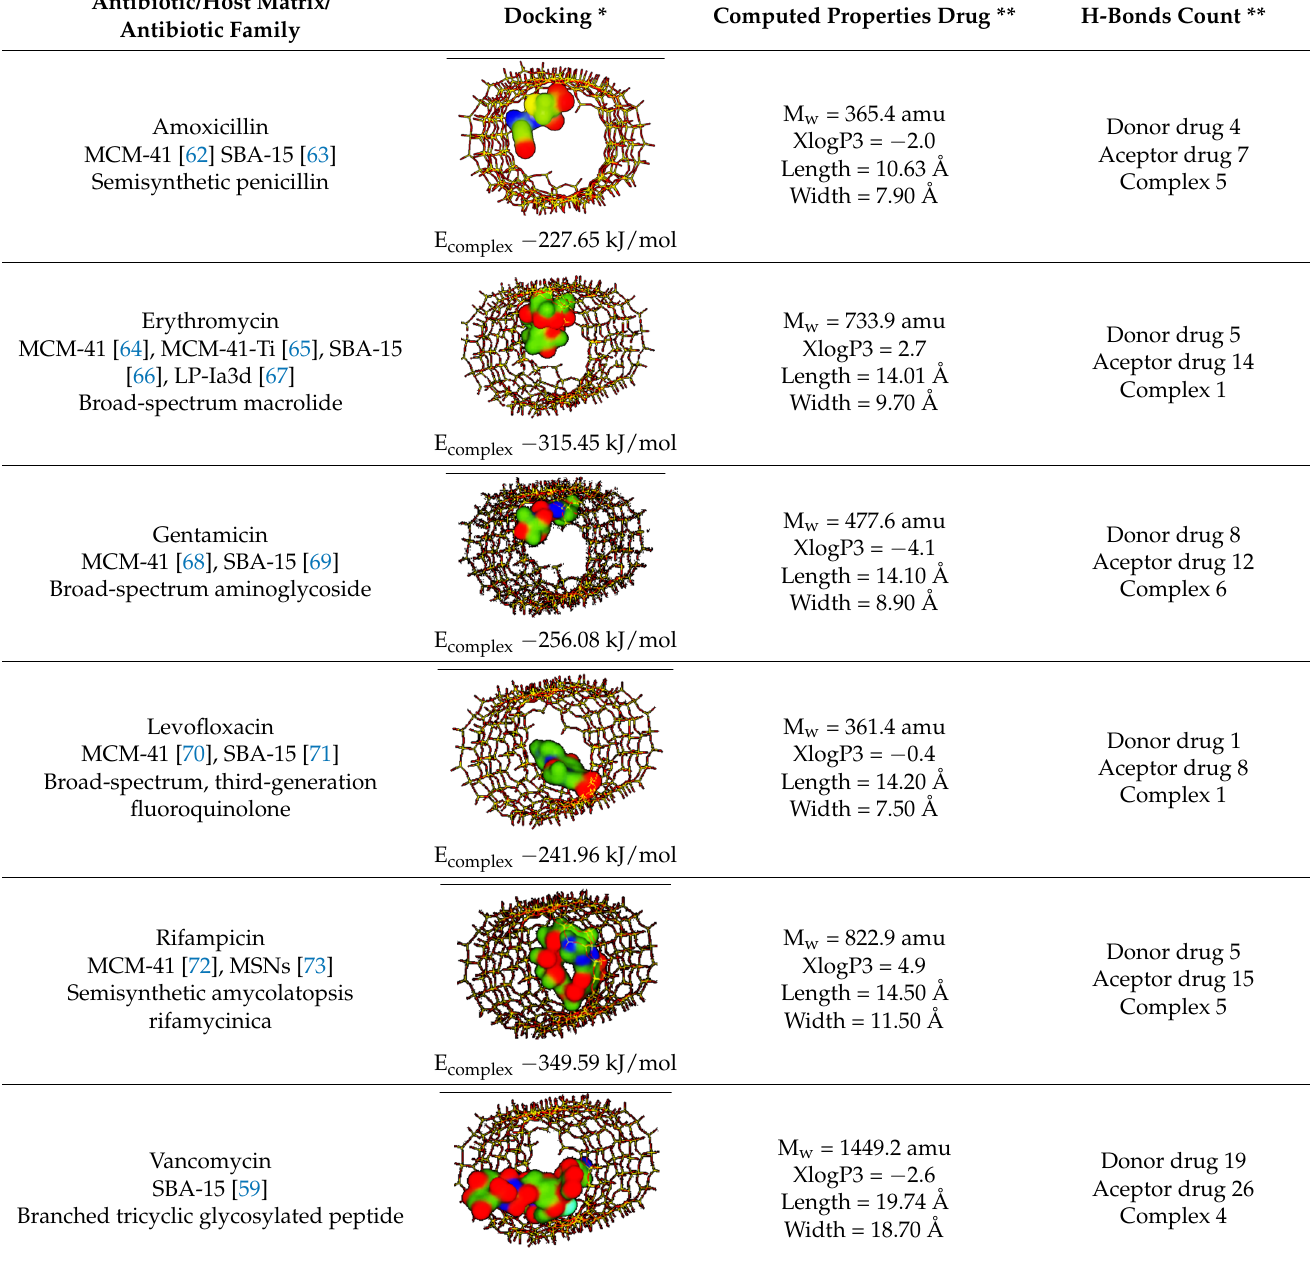
* MCM-41 host matrix is essentially composed of negative formal charges; in drugs, red represents negative formal charges while the blue color represents positive formal charges, as shown in the electrostatic potential color scale: ; E complex is the electrostatic potential energy in the model complex, where MCM-41 was used as recep- tor and the antibiotic as ligand. ** XlogP3 (for the fast calculation of partition coefficient, logP), donor and acceptor drug H-bonds have been obtained from PubChem DataBank. Complex H-bonds have been obtained from Hex 8.0 docking software.